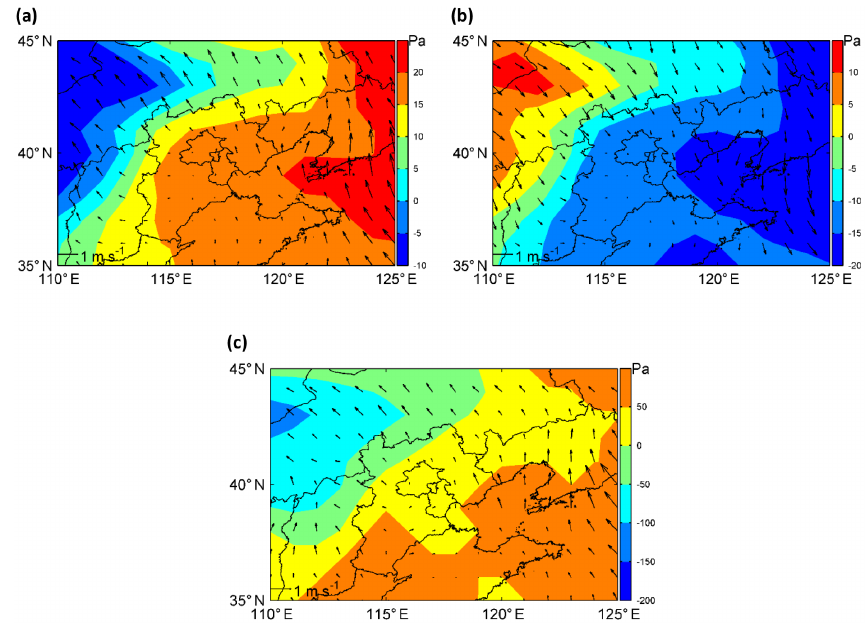
Figure 5. The MSL and 10m wind anomalies over the north China region. (a) SSTA larger than zero; (b) SSTA less than zero; (c) Decem- ber